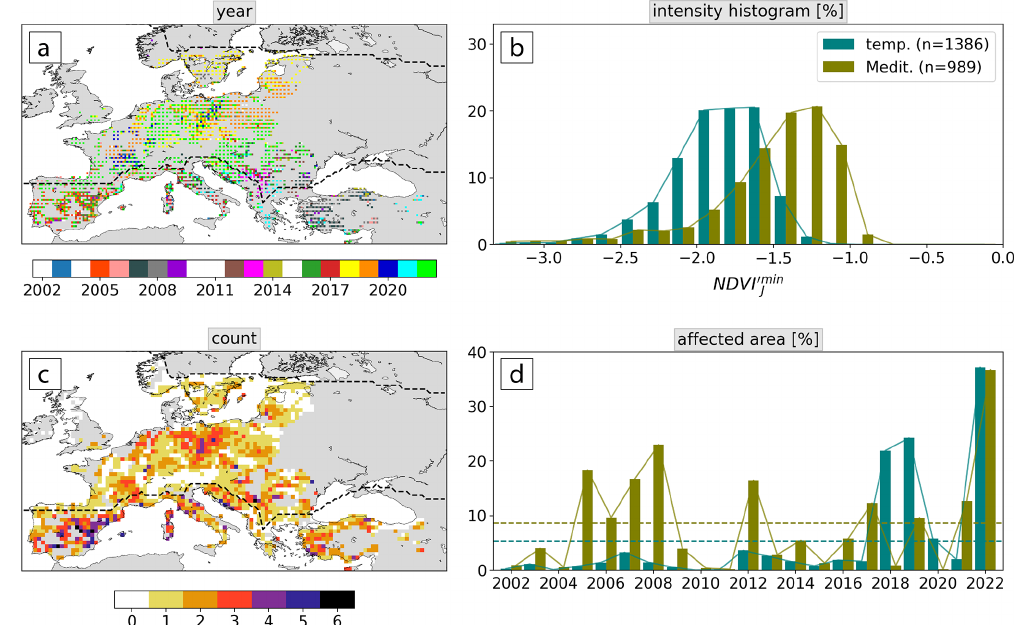
Figure 2. Maps of (a) years with a low-NDVI event (Appendix C) and (c) total number of events. (b) Histogram of event intensity as measured by NDVI (cid:48) min J in the two biomes and (d) time series of the biome-integrated area of low-NDVI grid cells relative to all forest grid cells (in %). Years with few low-NDVI grid cells are shown in white in (a) . In (a) each grid cell is split into four parts, showing the event year of up to the four most intense events. Dashed lines in (d) show the average over all years. Dashed lines in (a) and (c) delineate the temperate and Mediterranean